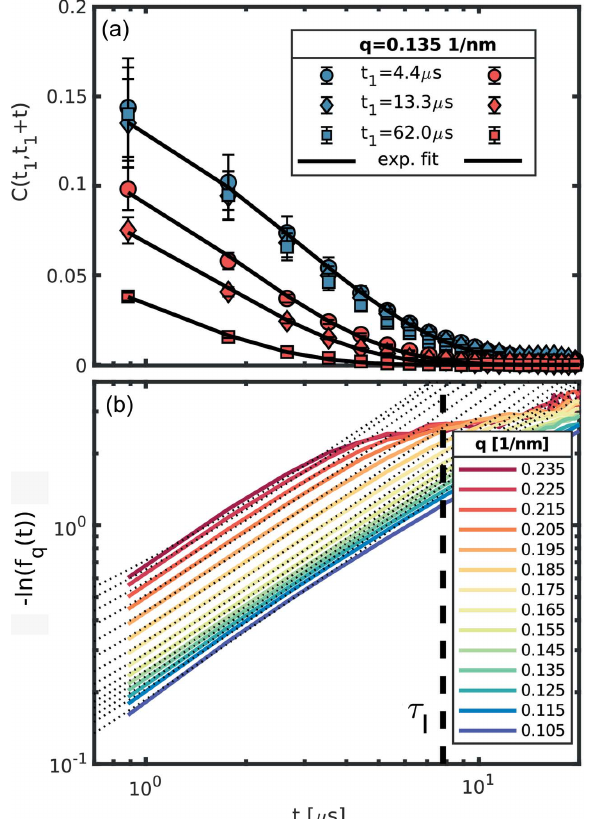
Figure 3 ( a ) Correlations obtained after 4.4 m s (circles), 13.3 m s (diamonds) and 62.0 m s (squares) hitting the sample with a fluence of 3.9 mJ mm (cid:2) 2 (blue symbols) and 10.5 mJ mm (cid:2) 2 (red symbols). The black lines are exponential fits to the data. Within the sensitivity given by the XFEL intensity fluctuations, the dynamics within a train of pulses remain